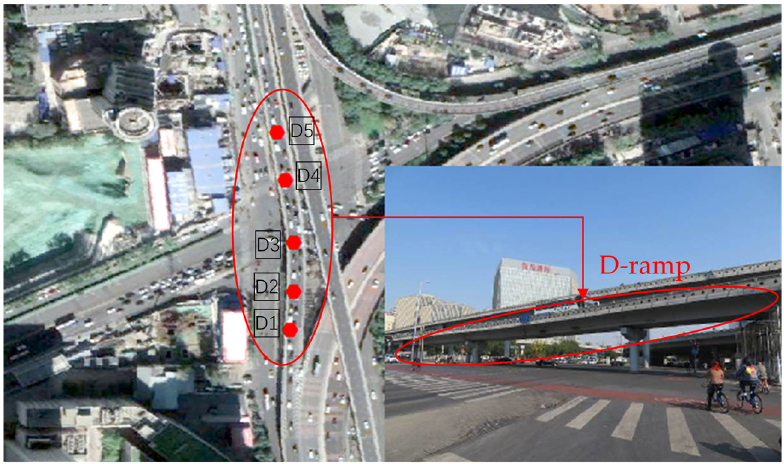
Figure 1. Suzhou Bridge D-ramp and its piers in Cosmo-SkyMed SAR image and scene picture.